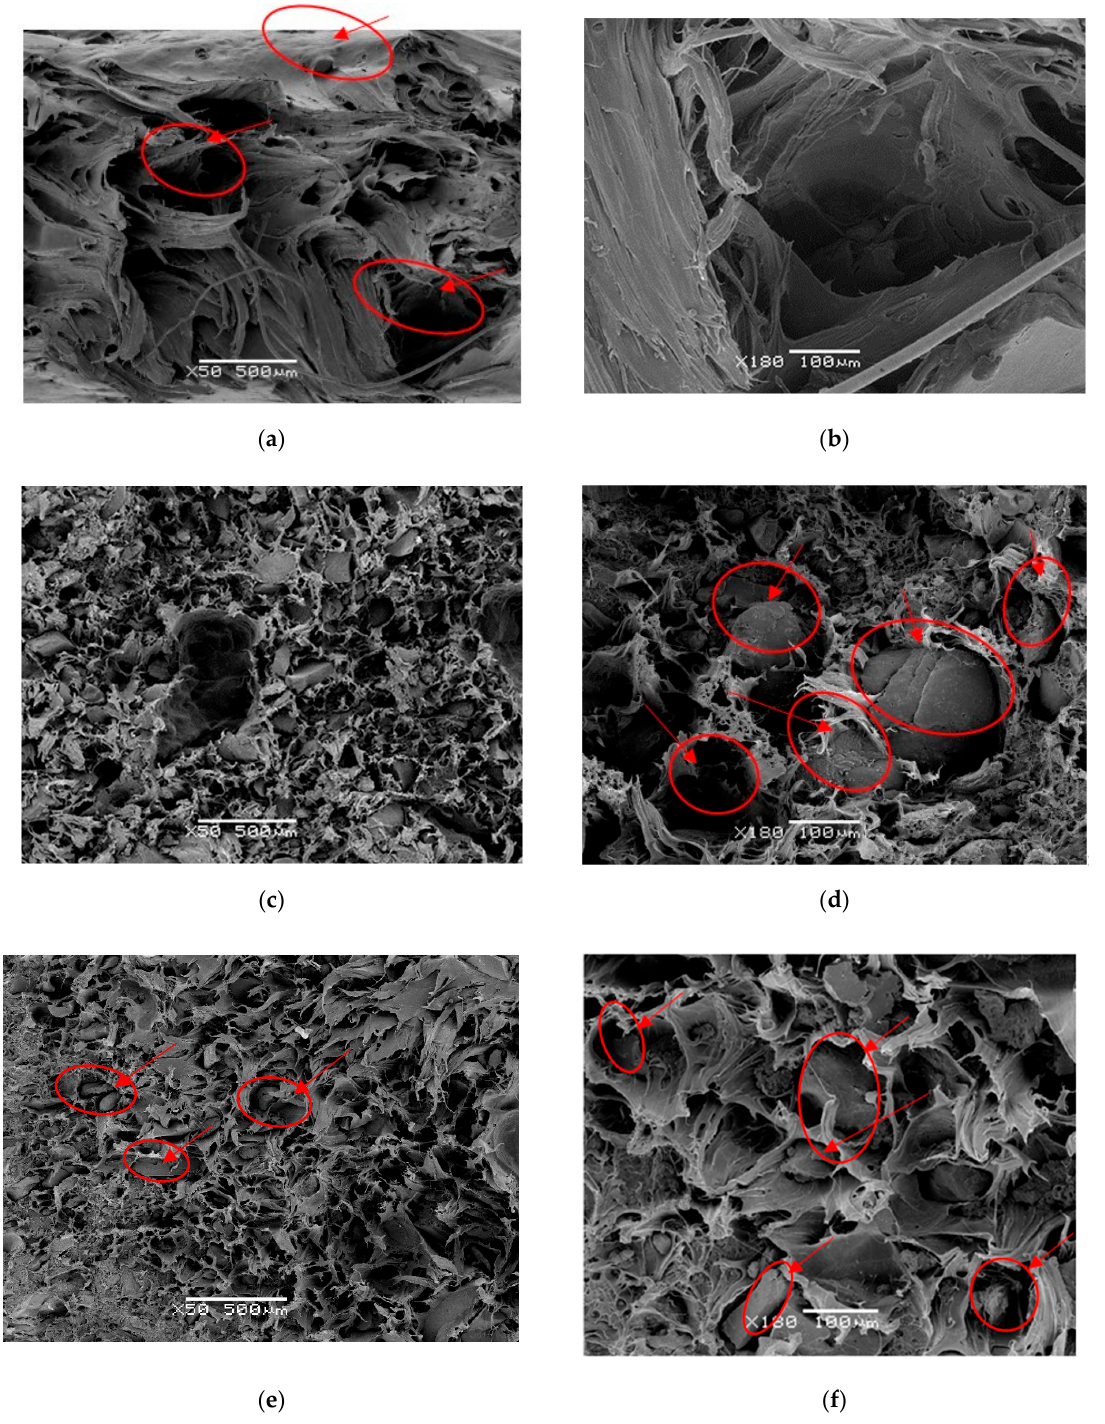
Figure 3. ( a ) 90% HDPE, ×50 a magnification image, ( b ) 90%HDPE, ×180 magnification image, ( c ) 80% HDPE, ×50 a magnification image, ( d ) 80%HDPE, ×180 magnification image, ( e ) 60% HDPE, ×50 a